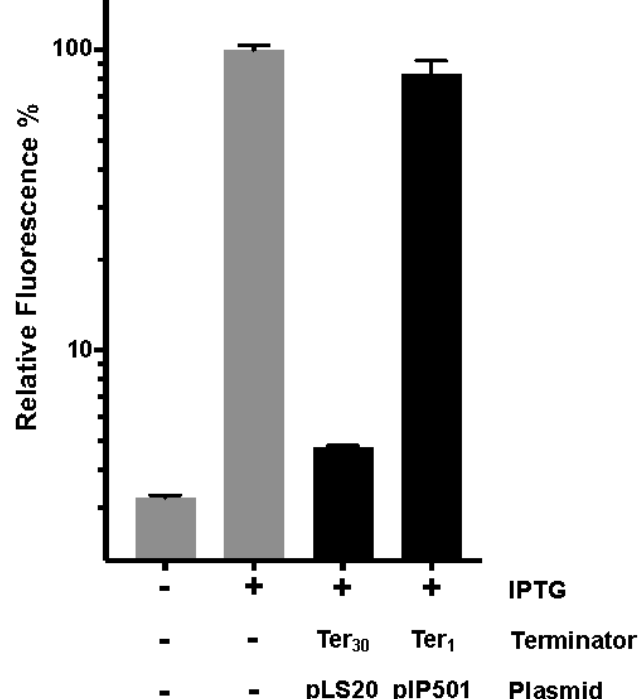
Figure 3. Fluorescence levels determined by flow cytometry analysis of cells grown in the absence or presence of 1 mM IPTG. Samples were withdrawn from late exponentially growing cultures (OD 600 between 0.8 and 1). Gray bar: control strain AND101 (P spank - gfp ). Black bars: strains AND127 (P spank -[Ter 30 ]- gfp ), indicated as Ter 30 , pLS20, and EEF7 (P spank -[Ter1]- gfp ), right bar indicated as Ter 1 , pIP501. Fluorescence levels are expressed as the mean value of the Geomean values of 100,000 cells obtained in three independent experiments. Error bars represent standard deviation.